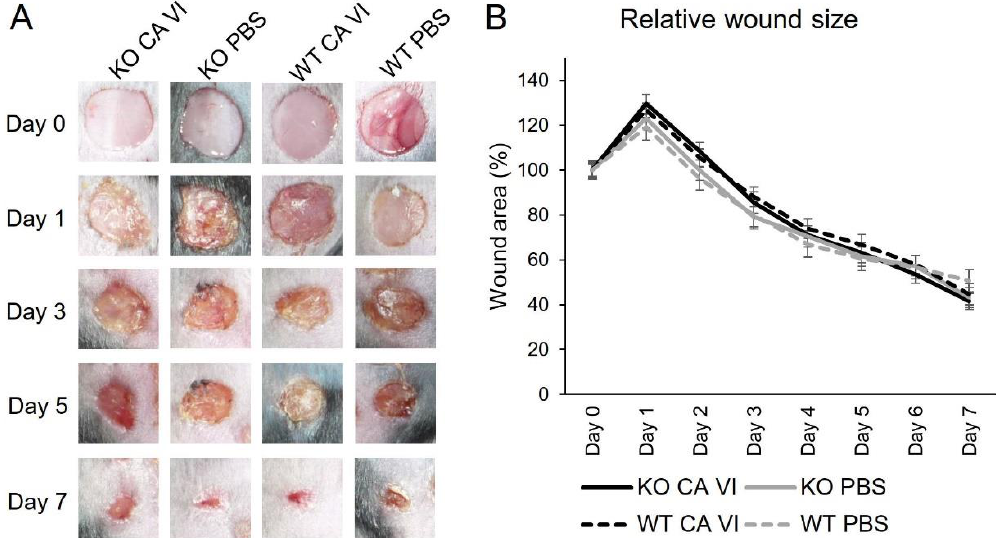
Figure 2. The purified CA VI and macroscopic analysis of the wounds. ( A ) Examples of skin wounds at different timepoints. ( B ) The wound sizes relative to the size on the wounding day (day 0) were calculated from the measurements of digital photographs. Error bars represent SEM, n = 8. No statistically significant difference was observed by analysis of variance.